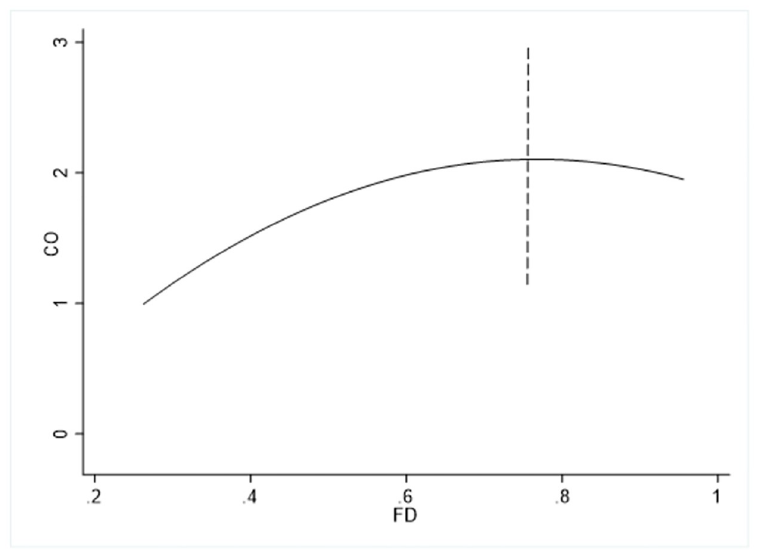
Fig 2. Line chart of financial development and CO2